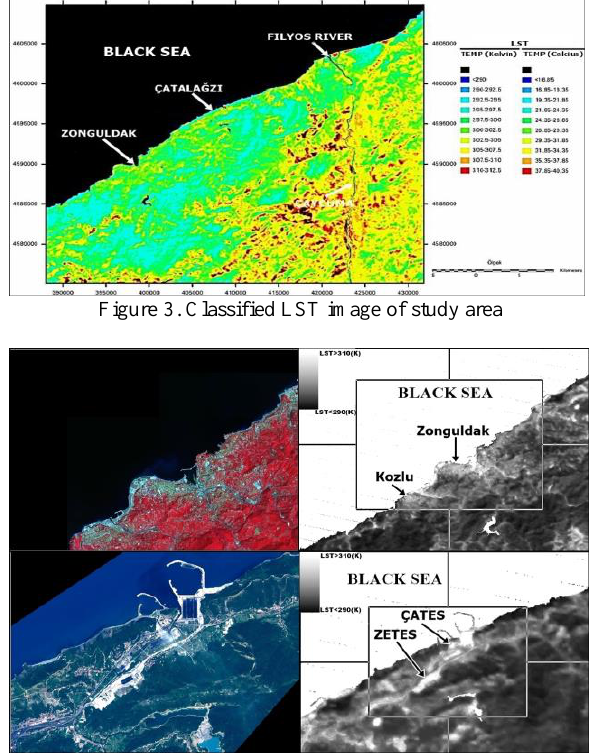
Figure 4. Association of high resolution images (left) and LST image (right)